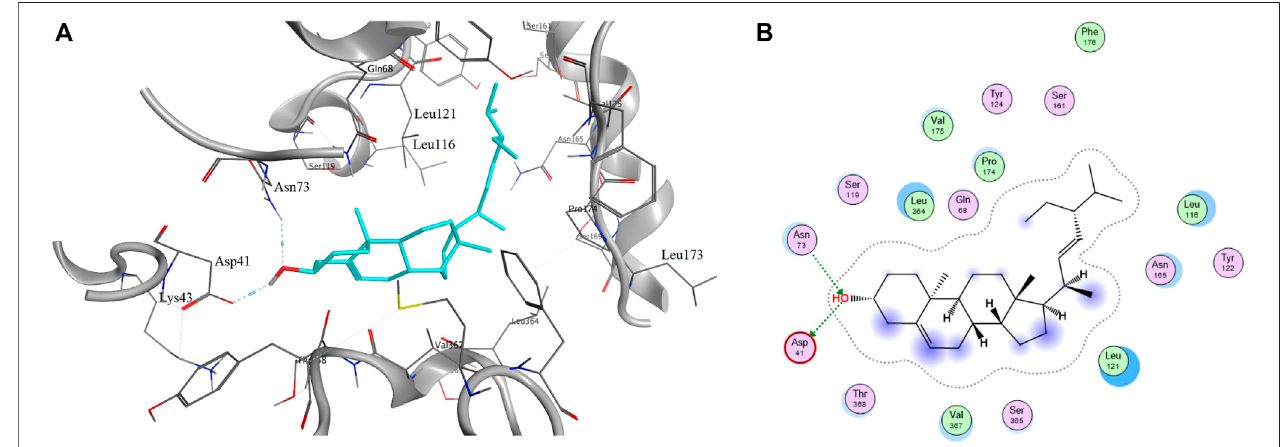
FIGURE 6 | Binding mode of protein 6QD5 with molecule AI07 from LCS. Note: A and B are the 2D and 3D binding mode,